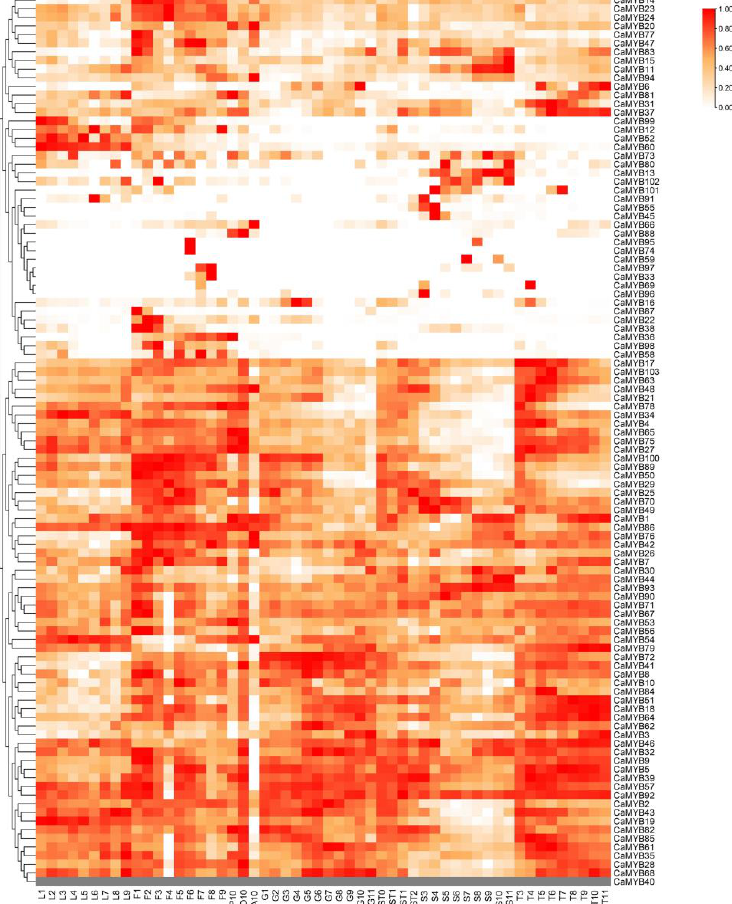
Figure 5. Expression patterns of CaMYB -related genes in different tissues and organs of pepper based on transcriptome data. L, F, O, G, S, and T represent the leaf, flower, ovary, pulp, seed, and placenta, respectively. ST denotes early seed and placenta, FST denotes early whole fruit, P10 denotes petal, and STA denotes stamen. Dark colors indicate high expression levels, and light colors indicate low expression levels.